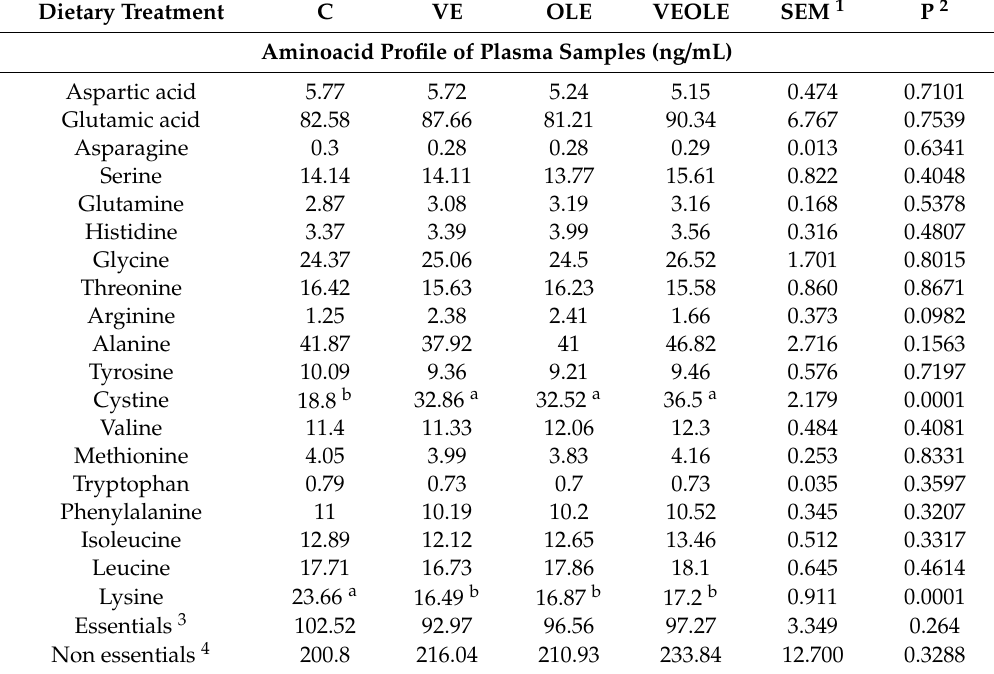
Table 2. Amino acid profile of plasma samples at slaughter from pigs fed the experimental diets (C, control; VE, vitamin E + Se; OLE, oleuropein extract; VEOLE, vitamin E + Se + oleuropein extract). Dietary